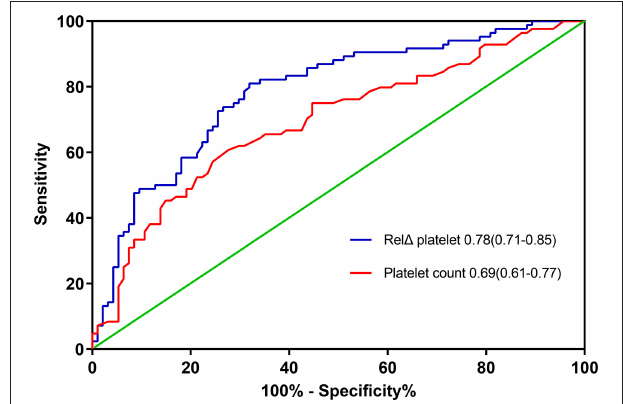
FIGURE 4 | The areas under the receiver operating characteristic curves for predicting in-hospital death. Rel 1 platelet, relative decrease in platelet